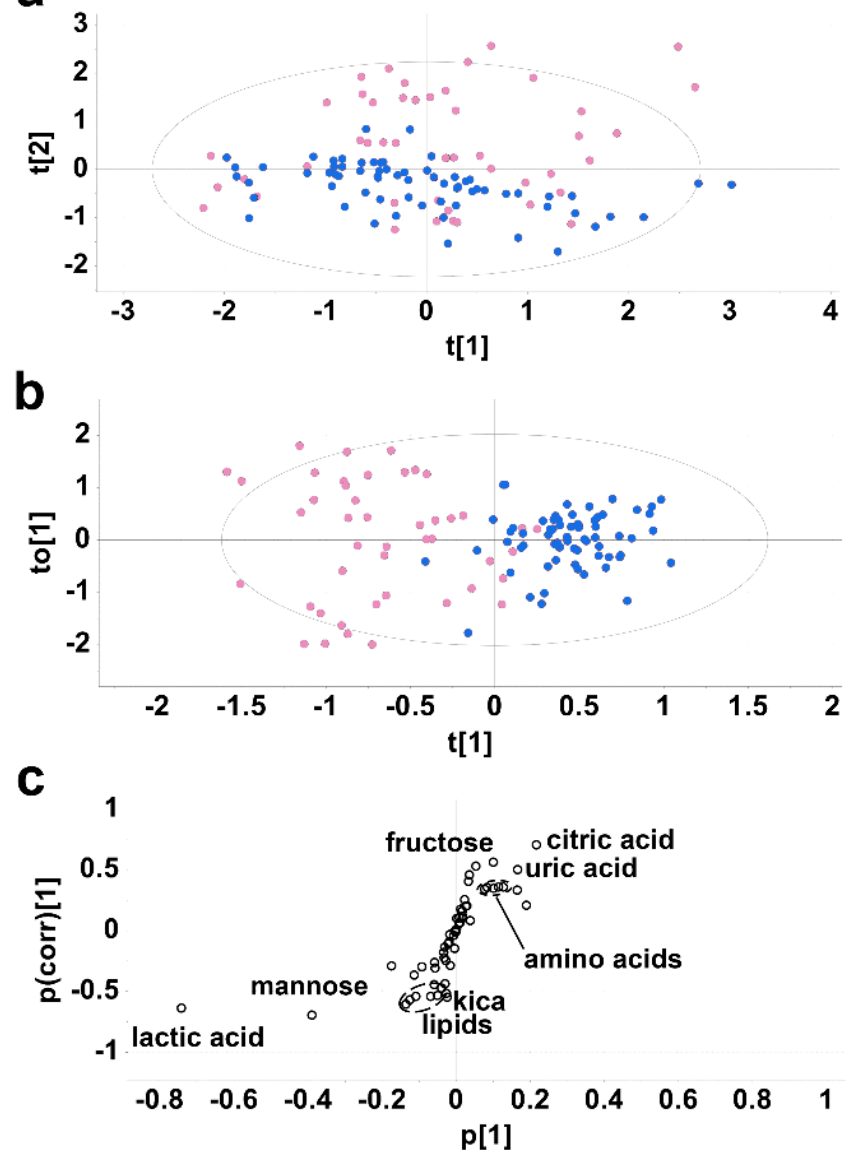
Figure 1. Multivariate data analysis of ascites metabolites vs. postoperative surgical drainage fluid metabolites. ( a ) Unsupervised PCA scores plot showing partial separation of cirrhotic ascites samples (blue) and surgical postoperative drainage samples (pink). Each point represents a sample analyzed by GC-MS. The Hotelling’s ellipse represents the 95% confidence boundary. ( b ) Supervised OPLS-DA scores plot showing clustering and separation of ascites and surgical drainage samples. ( c ), OPLS-DA loadings S-plot showing metabolites upregulated in ascites fluid (top right) and metabolites downregulated in ascites relative to control drainage fluid (bottom left). The X -axis (p[1]) represents the variable magnitude and the Y -axis (p(corr)[1]) represents the reliability of the